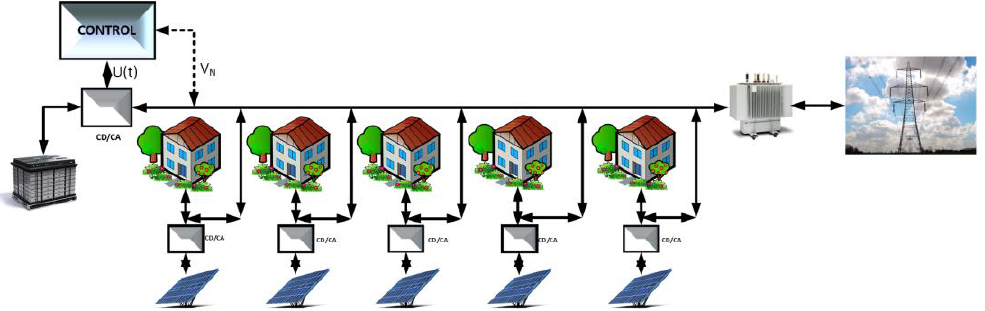
Figure 1. Proposed system. Figure 1.